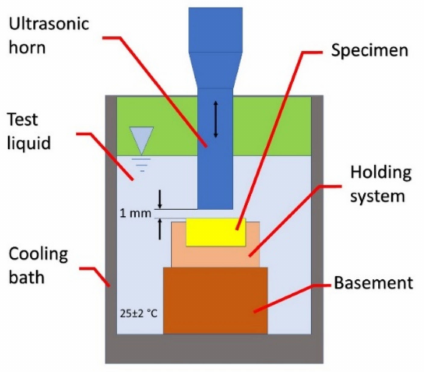
Figure 2. Schematic representation of the ultrasonic vibratory system used for